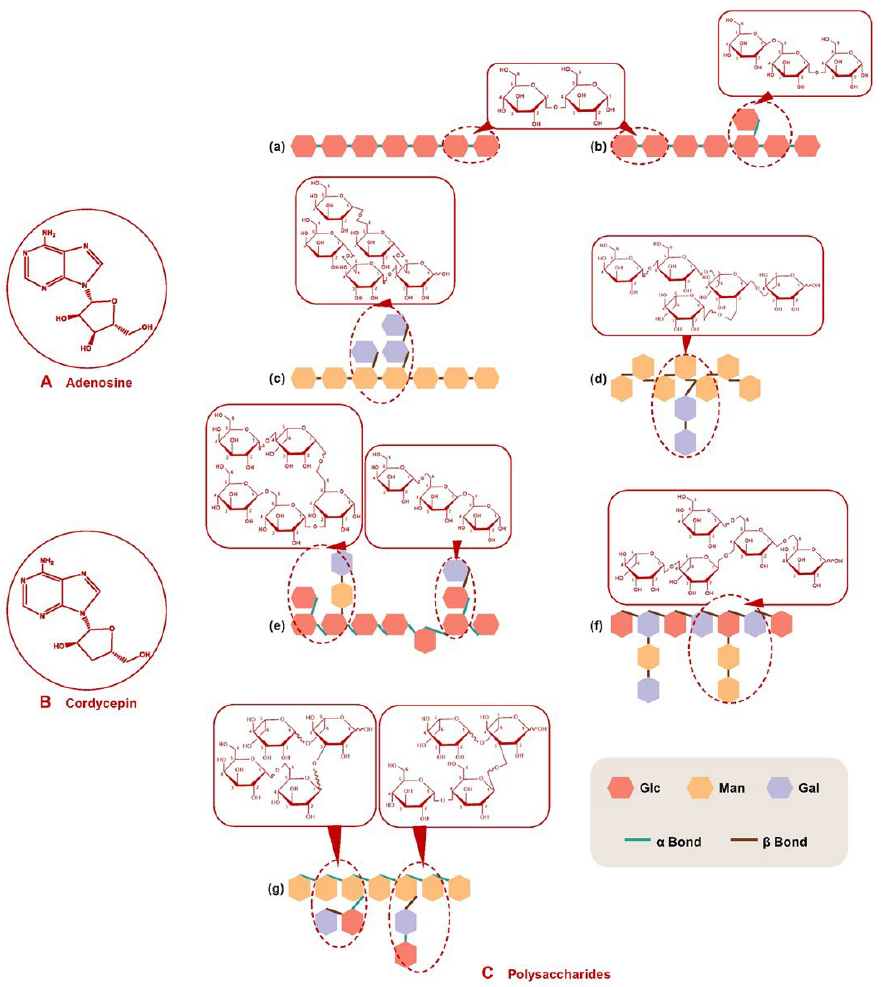
Figure 1. Chemical structure of adenosine ( A ), cordycepin ( B ) and polysaccharides ( C ) of Cordyceps spp. Illustration of the chemical structure of several Cordyceps polysaccharides: (a) (α1 → 4)-glucan; (b) (α1 → 6)- branched, (α1 → 4)- glucan; (c) (β1 → 6)- branched, (β1 → 4)-galactomannan; (d) (β1 → 4)- (β1 → 6)- branched, (β1 → 2)- (β1 → 6)- galactomannan; (e) (β1 → 4)- (β1 → 6)- (α1 → 6)-branched, (α1 → 3)- galactoglucmannan; (f) (β1 → 4)- branched, (β1 → 6)-galactoglucmannan; (g) (α 1 → 4)- (β1 → 6)- branched, (α1 → 6)-galactoglucmannan.